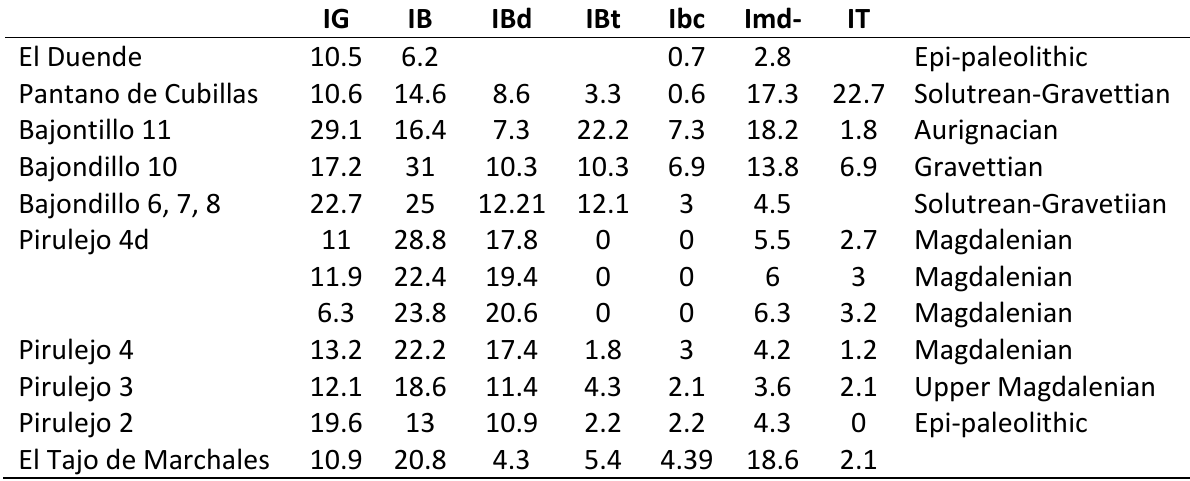
Table 1. Comparison with other material indexes of the zone. Abbreviations: IG - scraper index ("indice de rapadores" in Spanish); IB - burin index (Spanish: "indice de buriles"); IBd - dihedral burin index (Spanish: "indice de buriles dihedros"); IBt - burin index over truncation (Spanish: "indice de brusil sobre truncatura"); Ibc - drill-perforator index (Spanish: "indice de perforadores"); Imd - shoulder and denticulate index (Spanish: "indice de muescas y denticulados"); IT - truncation index (Spanish: "indice de